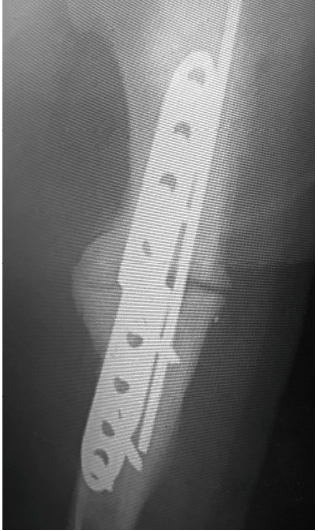
Figure 3. Post-operative view of callus formation.